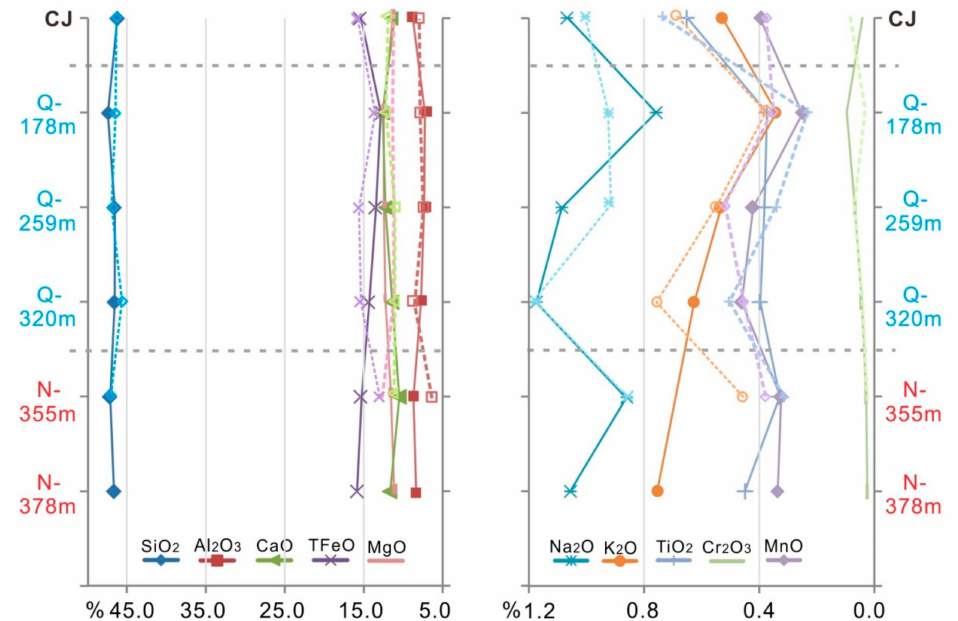
Figure 4. The mean element compositions of the amphibole of Core LQ24 and modern Changjiang River. A very fine sand fraction (63–125 µ m) is indicated by full lines and coarse silt (32–63 µ m) is indicated by dashed lines. Core depth is set in the vertical axis. CJ = Changjiang River. Core samples that were sampled from di ff erent depths of burial are marked in a red and light blue color. The red one is representative of the Pliocene; the light blue is representative of Pleistocene; N = Pliocene, Q = Pleistocene. Please see Table 1 for the numbers of grains analysed per sample.